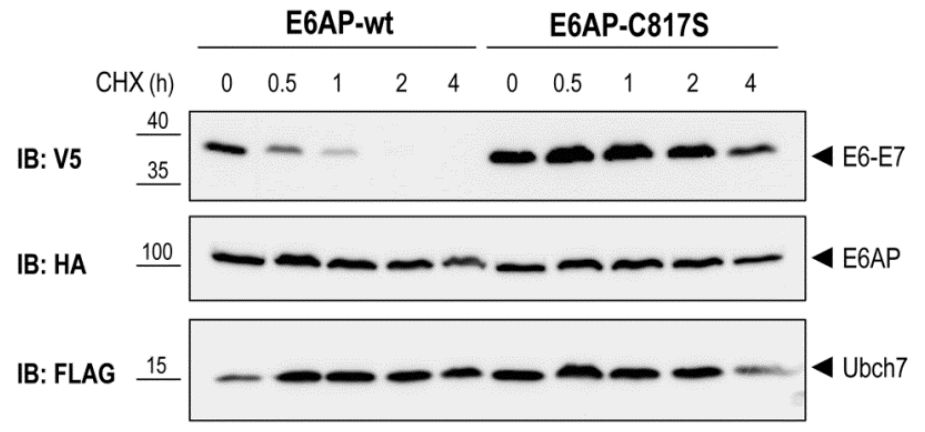
FIGURE 4: E6AP-dependent degradation of E6-E7 . Yeast